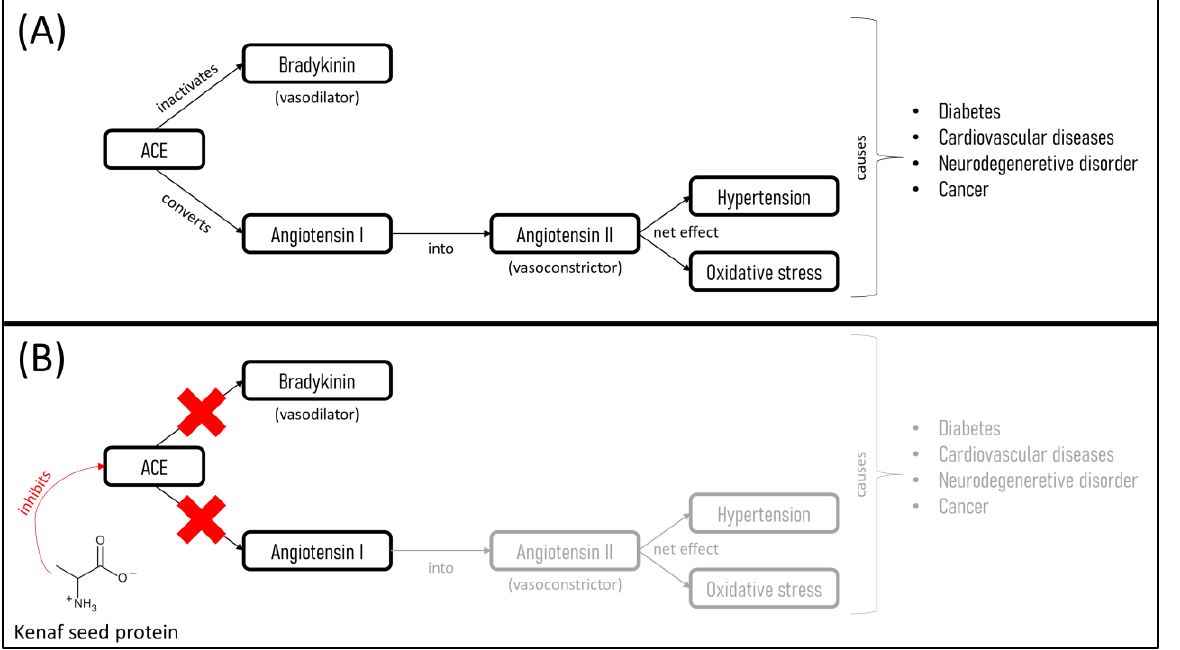
Figure 8. Graphical illustration of kenaf seed protein mechanism in addressing hypertensive conditions. ( A ) Without kenaf seed protein. ( B ) With kenaf seed protein. ACE: Angiotensin-converting enzyme I.